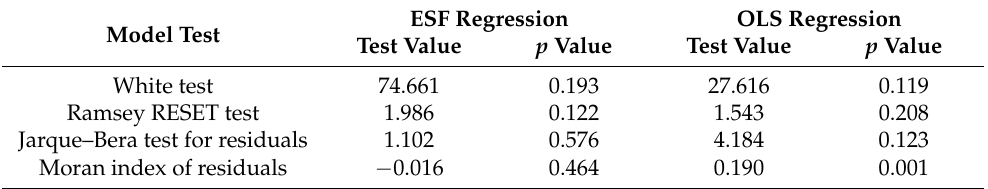
Table 12. Model test of OLS regression and ESF regression (ln(Night_V) as the dependent variable). Model